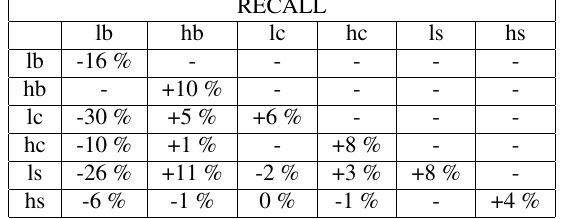
Table 2. Recall percentage values when using altered images in comparison to the recall values when using original, unaltered images